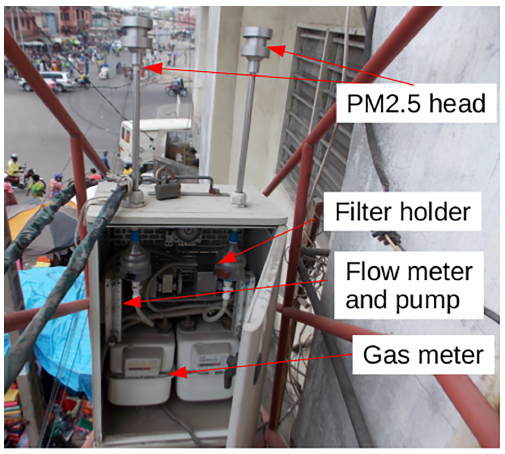
Figure 3. Picture of the sampling box standing outside at the CT site and showing the elements of the sampling